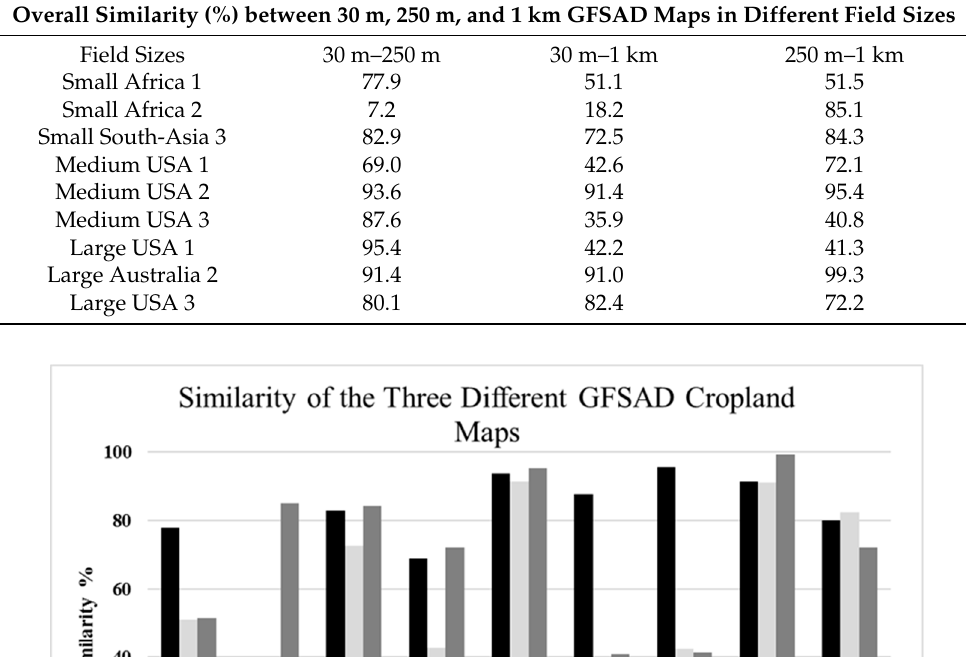
Table 14. Overall similarity between cropland extent maps with different resolutions.